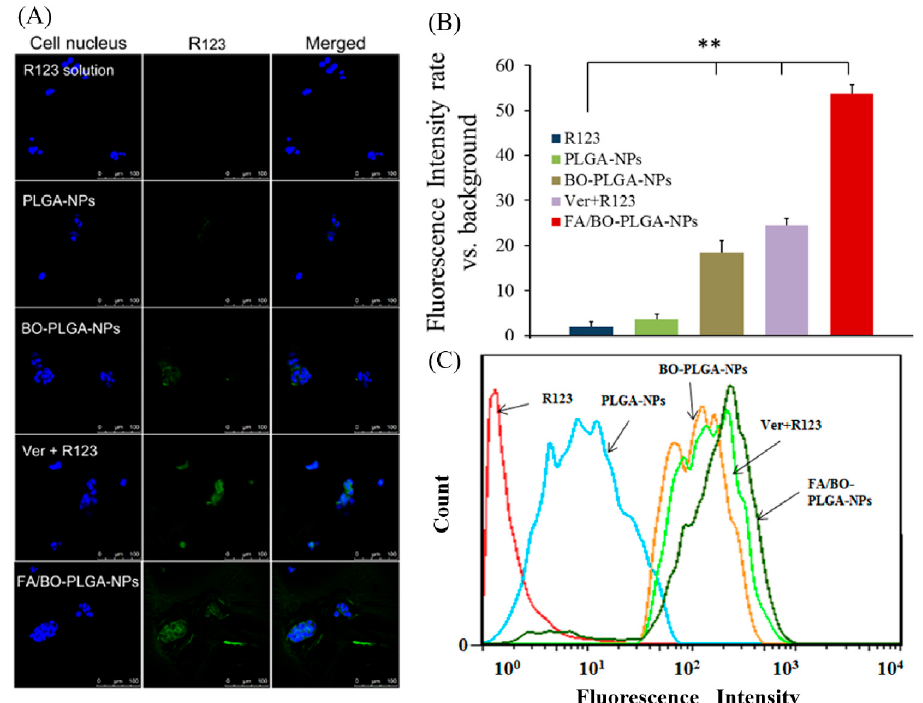
Figure 6. Confocal laser scanning microscopy (CLSM) images ( A ) and fluorescence quantitative analysis ( B ) of Caco-2 cells after incubation with R123, PLGA-NPs, BO-PLGA-NPs, FA/BO-PLGA-NPs, and the group of verapamil+R123 (Ver+R123) was set as the positive control group, with the concentration of verapamil being 0.3 mM (R123 concentration of 300 ng/mL) for 4 h. Columns from left to right correspond to DAPI, R123 and an overlay of DAPI and R123, respectively. Flow cytometry results ( C ) of Caco-2 cells treated with R123, PLGA-NPs, BO-PLGA-NPs, FA/BO-PLGA-NPs and the group of verapamil+R123 (Ver+R123) was set as the positive control group, with the concentration of verapamil being 0.3 mM (R123 concentration of 300 ng/mL) for 4 h. * p < 0.05, ** p < 0.01.